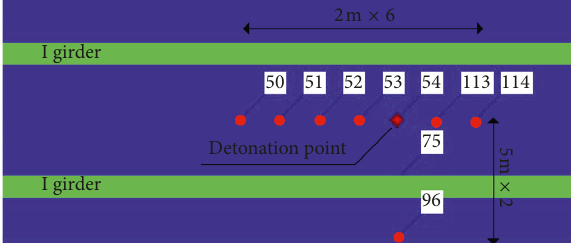
Figure 15: Defined gauges in case of down-deck detonation.